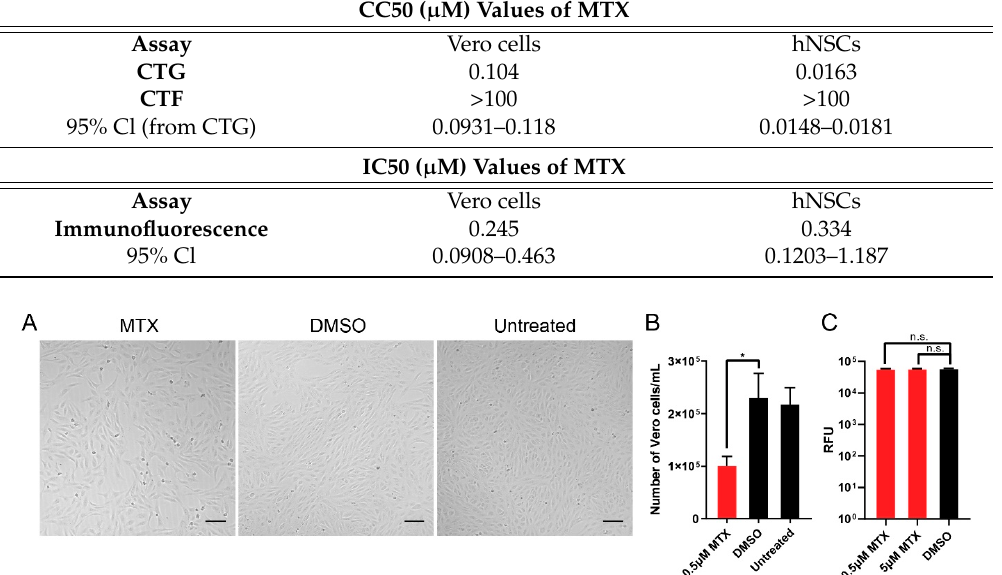
Figure 2. Determination of cytotoxicity of MTX. To determine the cytotoxicity of MTX, the number of Vero cells after MTX treatment was directly counted by trypan-blue staining. Then, the number of live cells were counted under a light microscope with a hemocytometer. ( A ) 10× bright-field images of Vero cells with 0.5 μ M MTX treatment with initial cell density of 10,000 cells/100 μ L. Scale bars represent 5 μ m. ( B ) The cell density of Vero cells after 0.5 μ M MTX treatment after incubation for 48 h at 37 °C and 5% CO 2 (NuAir, Plymouth, MN, USA). ( C ) Cell viability assay using CTF reagent with initial cell density of 30,000 cells/100 μ L. Two MTX concentrations (5 μ M and 0.5 μ M) were tested. At least two independent replicates were performed. One-way ANOVA, followed by Tukey’s multiple comparisons test, were used for statistical analysis. The error bars represent the standard error of the mean (SEM). * p ≤ 0.05